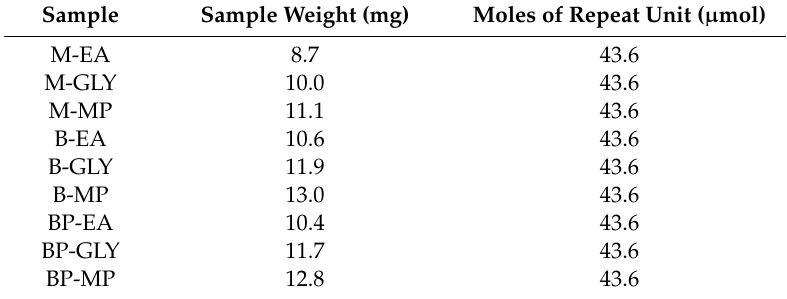
Table 2. Polymer amounts used in the 1 H-NMR degradation studies at pH 4.0, 7.0 and 9.0 a,b